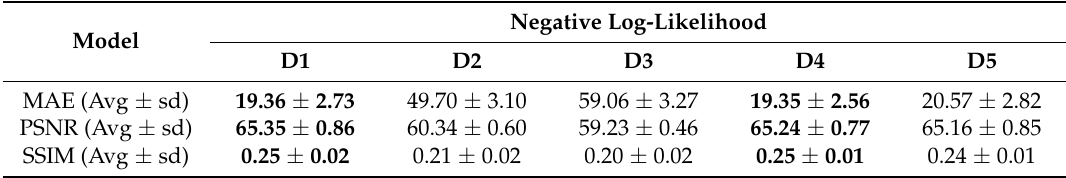
Table 4. Comparison of the MAE, PSNR, and SSIM for different discriminator networks and negative log-likelihood. The leading scores are displayed in bold fonts.